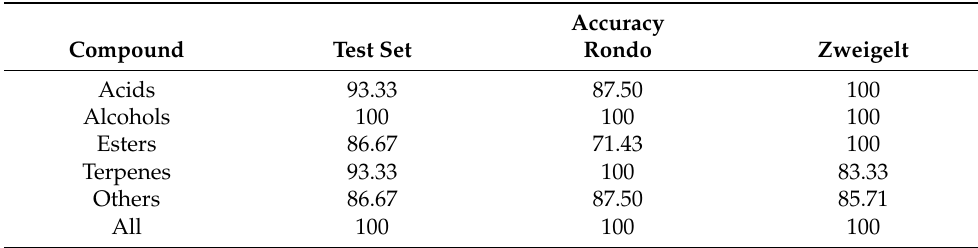
Table 2. Classification accuracy of SVM method in the test set and in the subsets of Rondo and Zweigelt wines (%).